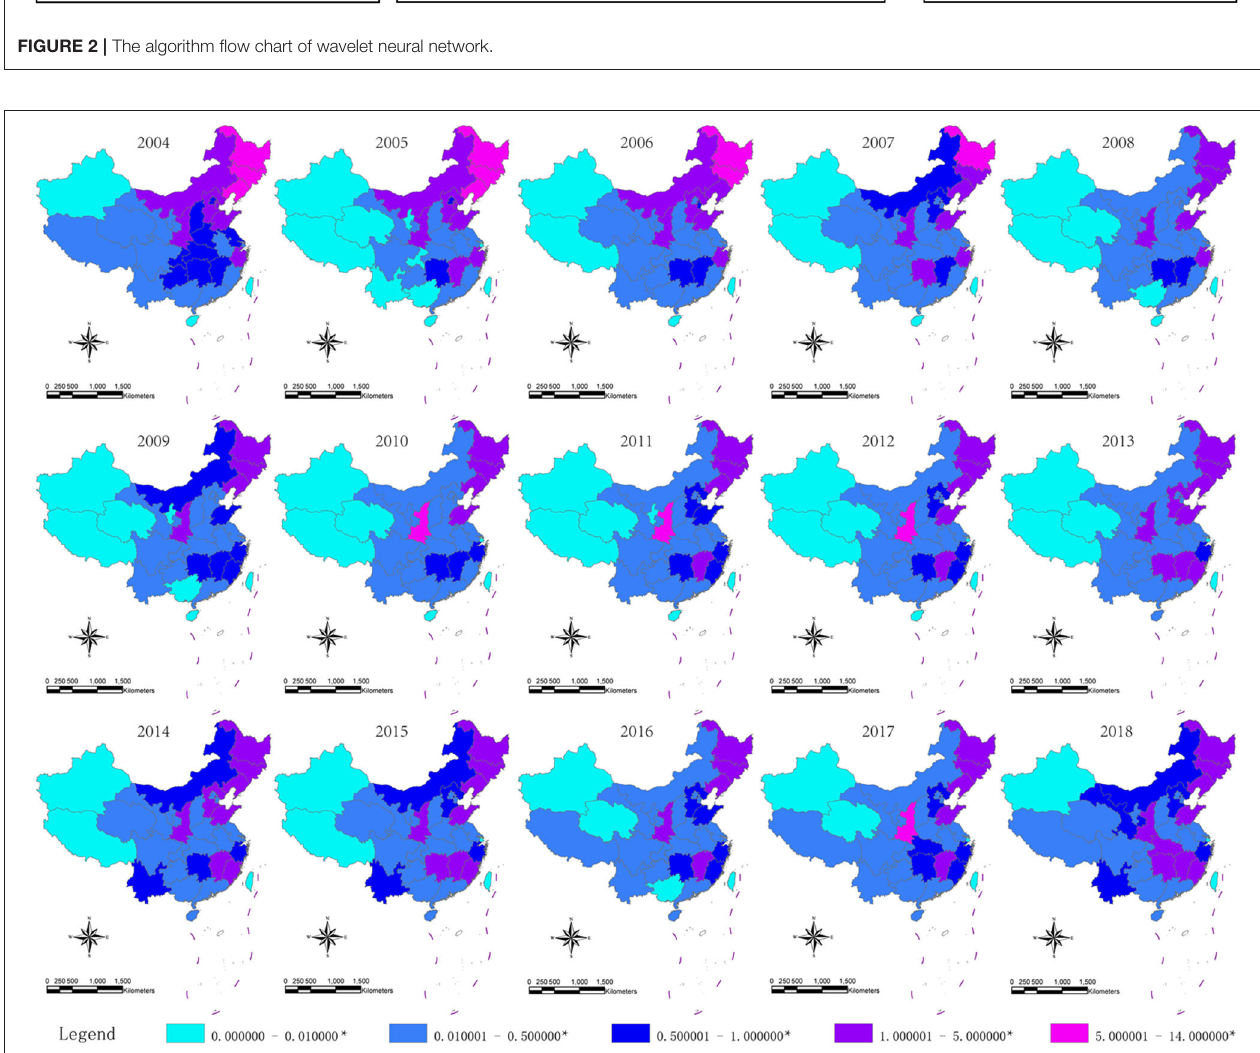
FIGURE 3 | Yearly distribution of HFRS incidence in China, 2004–2018. *Per 100,000 individuals. Geographical information system (GIS) maps are generated by software ArcGIS using the data of China Public Health Statistical